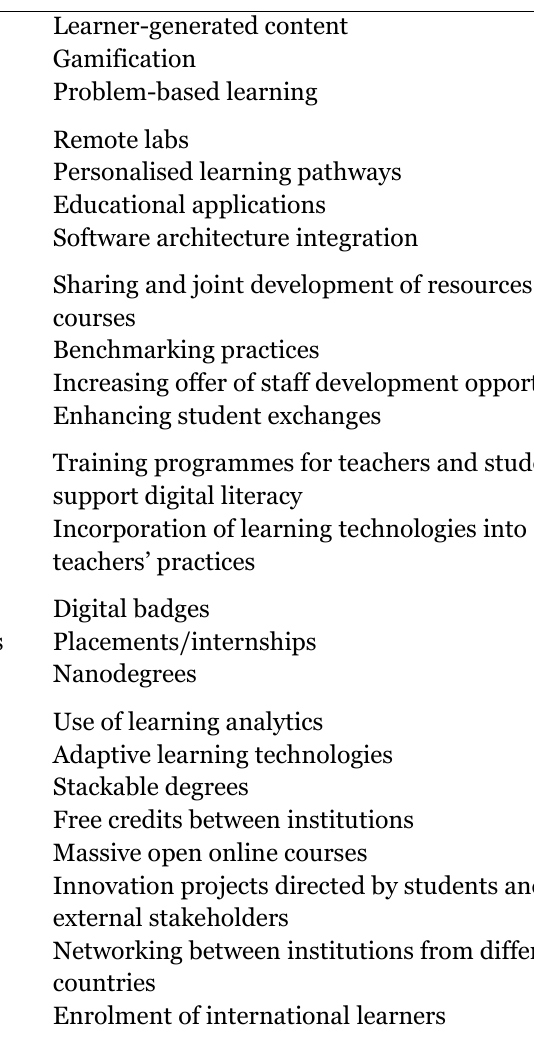
Themes of Innovative Practices and Original Approaches to Teaching in Higher Education